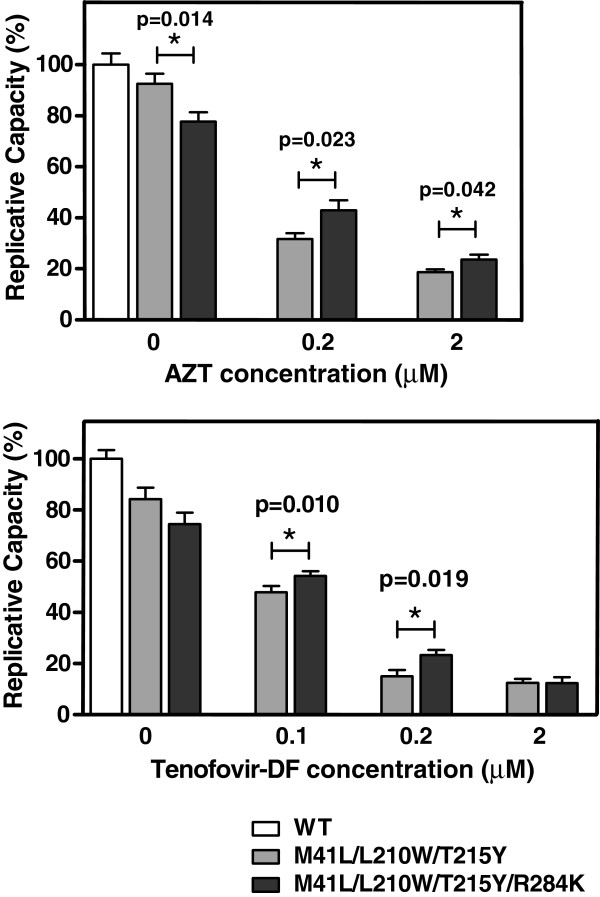
Replication kinetics of WT and mutant RTs in the absence and presence of AZT and tenofovir disoproxil fumarate (Tenofovir-DF). In each case, histograms show the relative replication capacity (%), compared to the WT virus in the absence of drug, based on the slopes of p24 antigen production of each recombinant virus after infection of stimulated PBMCs. The significance of the difference between slopes was calculated using the GraphPrism v. 4 software and significant p values are represented above the bars. Statistical analyses were performed by using a Student t test.